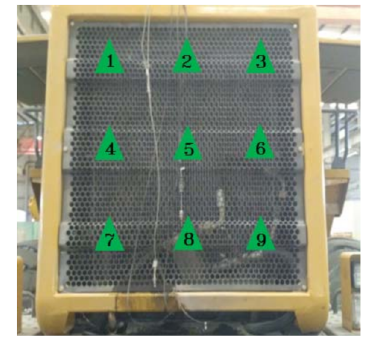
Figure 4. Flow rate collection points of experiment.